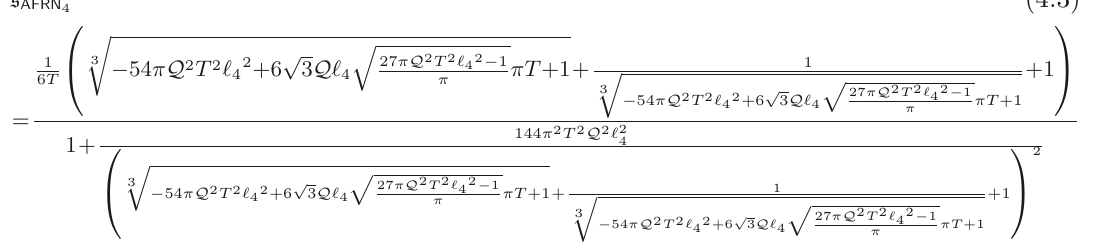
JHEP02(2023)072